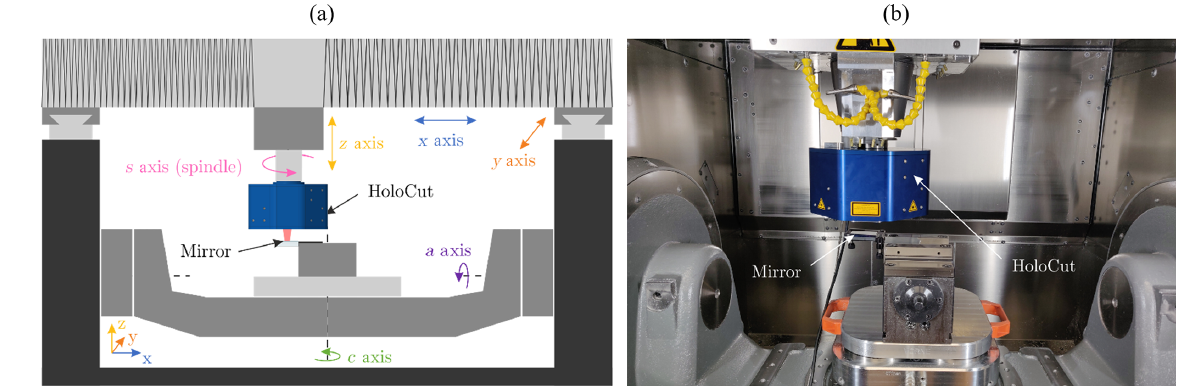
Figure 4. (a) Schematic sketch of the machine tool with its moving axes and integrated HoloCut sensor head measuring in the z direction. (b) Photograph of the real